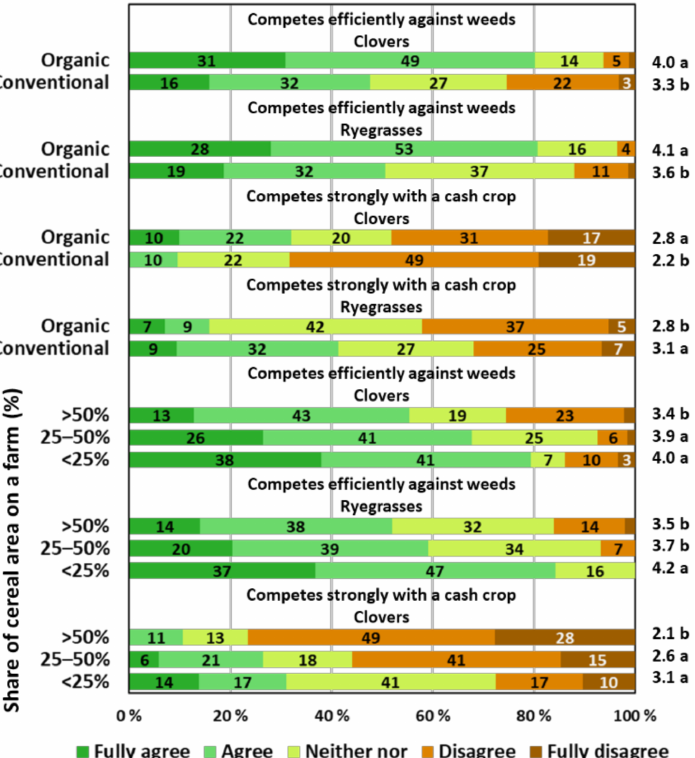
Figure 10. The distribution and mean of farmers’ experience-based answers to the statements about competition of under-sown clovers and ryegrasses against weeds and with cash crop depending on farming system and the share of the cereal area on a farm. See more details in Figure